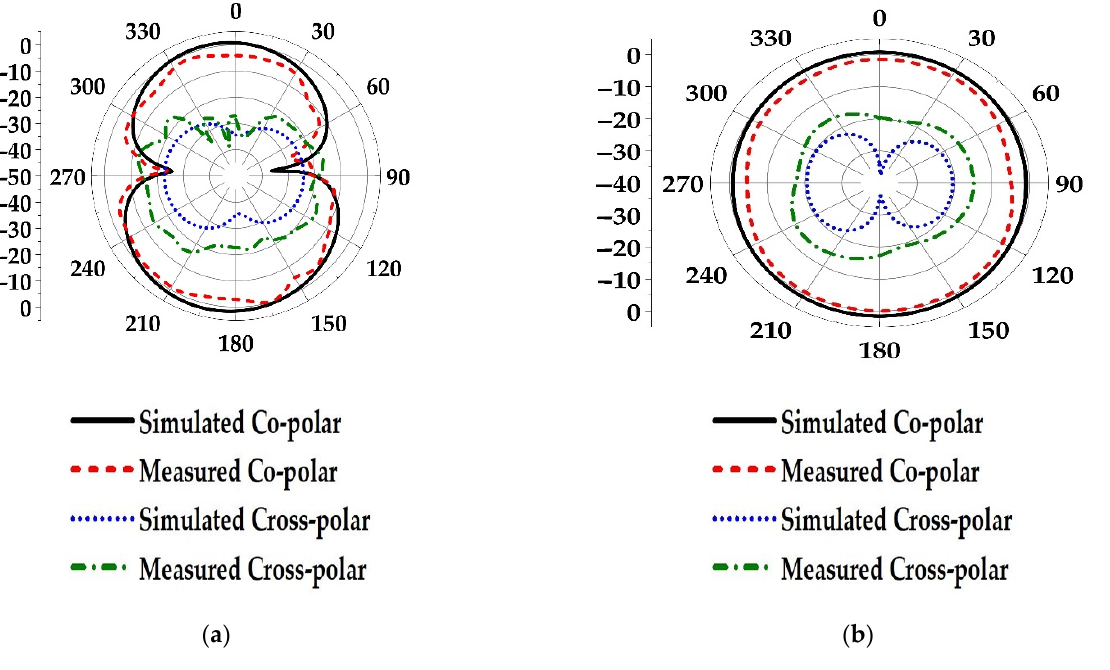
Figure 15. Simulated and measured radiation patterns of the proposed antenna. ( a ) YZ-plane (elevation plane), ( b ) XY-plane (horizontal plane).